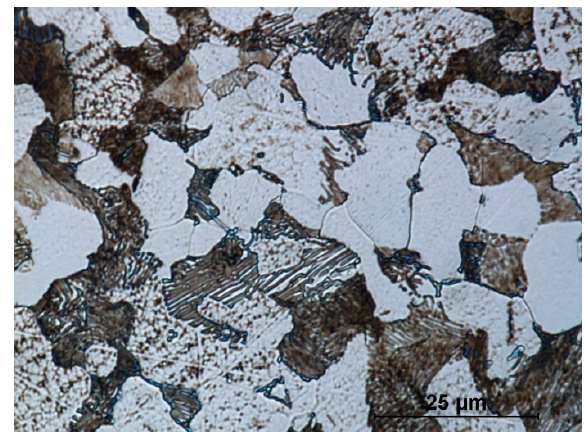
Figure 12. Microstructure of C45 steel in delivery condition.